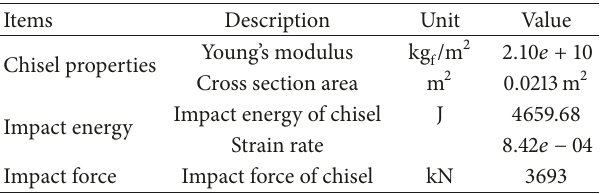
Table 3: Results of impact energy